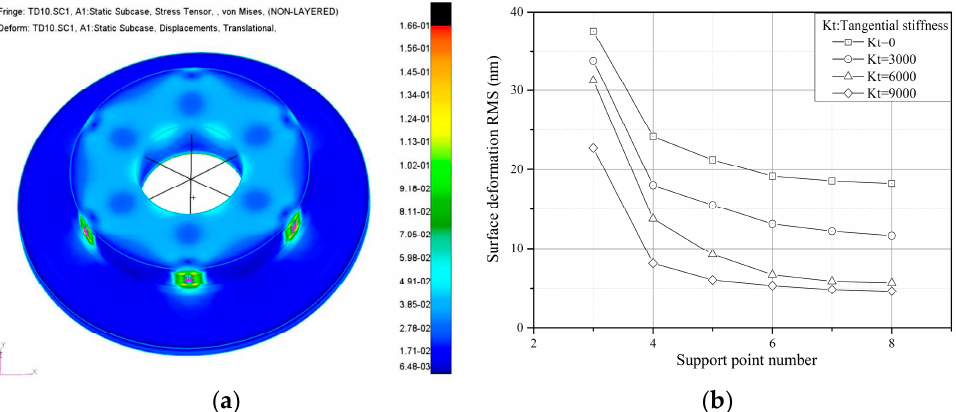
Figure 4. ( a ) FEA model, ( b ) Surface RMS vs. support point number. FEA model and TCML induced surface deformation sensitivity curve.